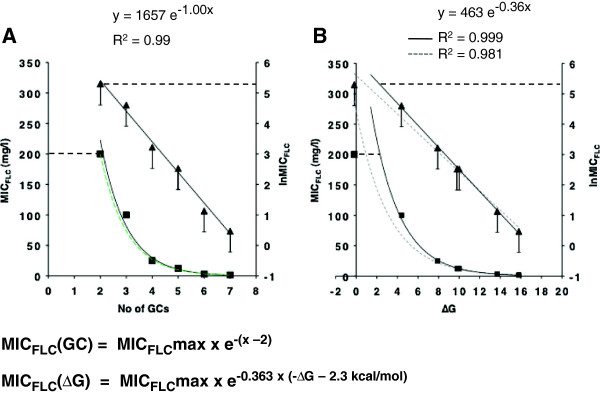
Cdr1p expression levels decrease exponentially with an increase in the number of GC-pairs in stems containing only GC-pairs 5′ proximal to the AUG start-codon. A. The relationship between MICFLC values of Cdr1p-expressing strains and the number of GC-pairs in stems containing only GC-pairs. Black squares represent MICFLC values and black triangles represent the lnMICFLC values plotted against the number of GC-pairs in stem-loop constructs. The two black lines represent the trend lines for the best fit of these two data sets (‘error’ bars indicate the possible range of MICFLC values of individual constructs; see text for further details). The horizontal black dashed lines mark the MICFLCmax values of wild type Cdr1p-expressing cells. The green dashed trend line is the trend line that was created with the calculated MICFLC values for stem-loop constructs containing only GC-pairs using the formula shown underneath. B. The relationship between MICFLC values of Cdr1p-expressing strains and the calculated ∆G values for stems containing only GC-pairs. The same symbols as in A were used. The dashed grey lines are the trend lines for the best fit including the data point for the construct containing 2 GC-pairs, while the two black lines represent the trend lines for the best fit of the data sets excluding that data point. The formula that can predict the MICFLC values for stem-loop constructs containing only GC-pairs using their calculated ∆G values is shown underneath. All MICFLC values are the values for three independent transformants and did not vary by more than one dilution.